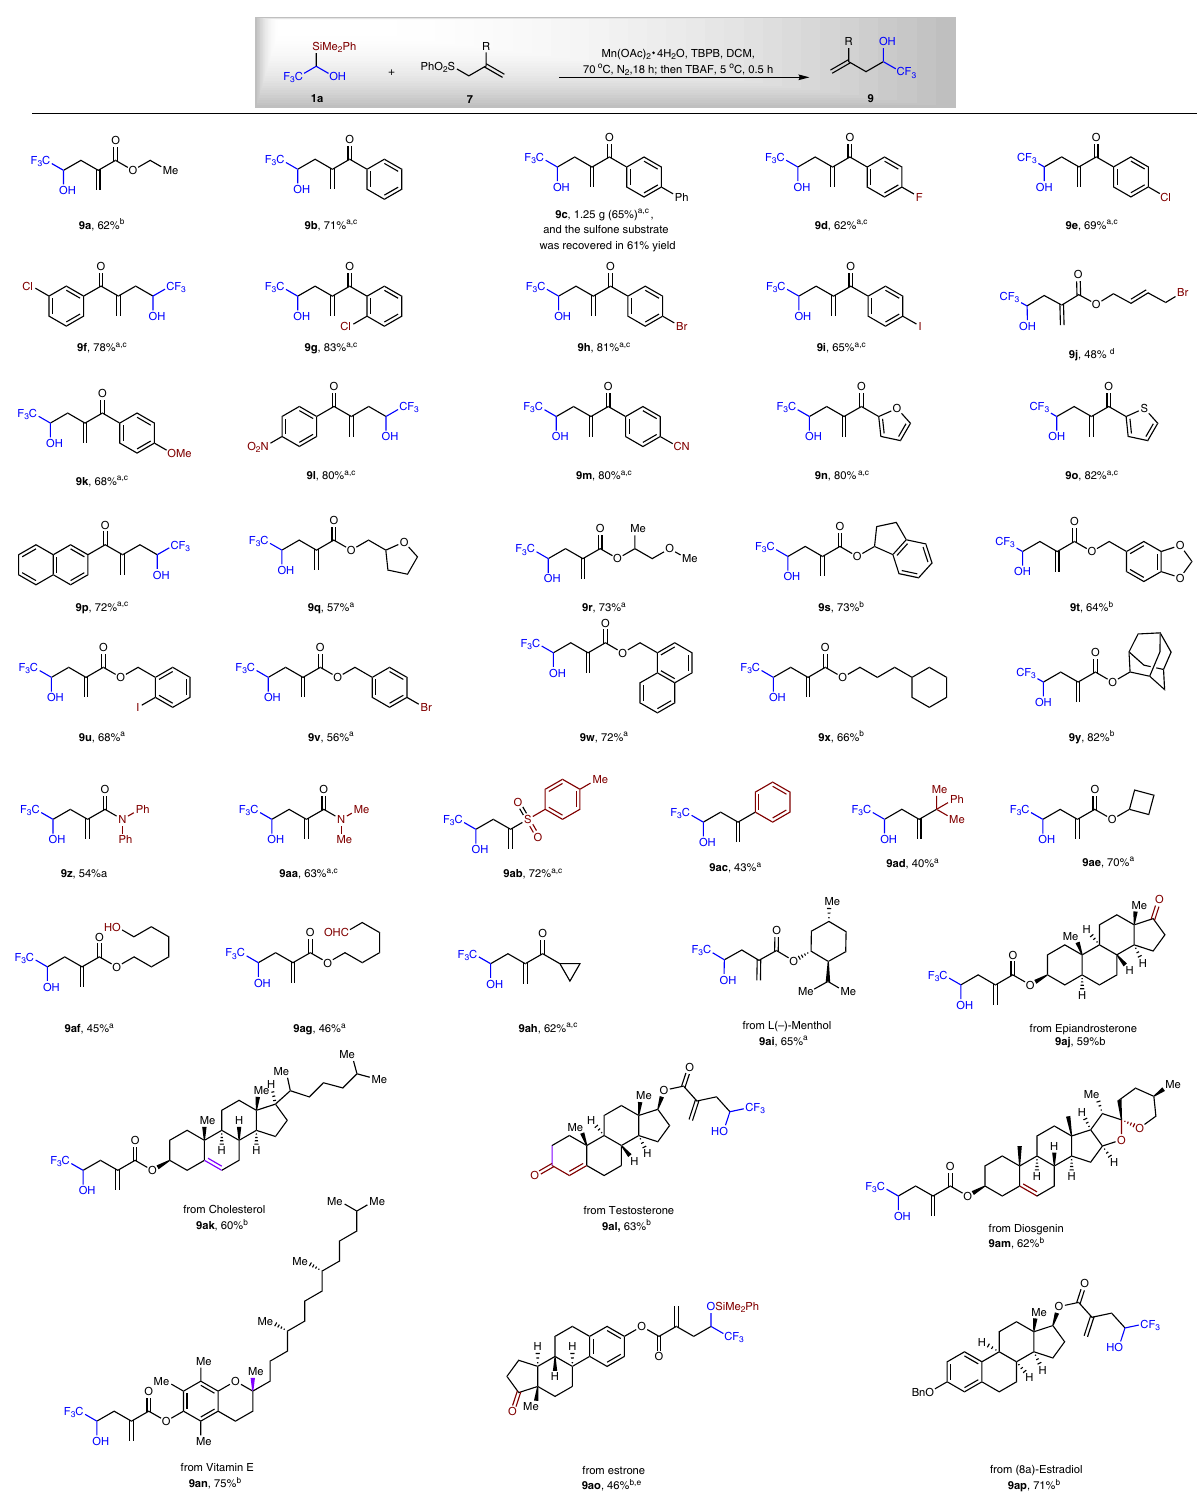
Fig. 4 Scope for the allylation of reagent 1a. a 1a/ 7 = 1/3, b 1a / 7 = 1/2, and c Mn(OAc) 3 ·2H 2 O was used instead of Mn(OAc) 2 ·4H 2 O. d 2 equivalent of Mn (OAc) 3 ·2H 2 O was used without TBPB. e Instead of TBAF, water was used to quench the reaction.